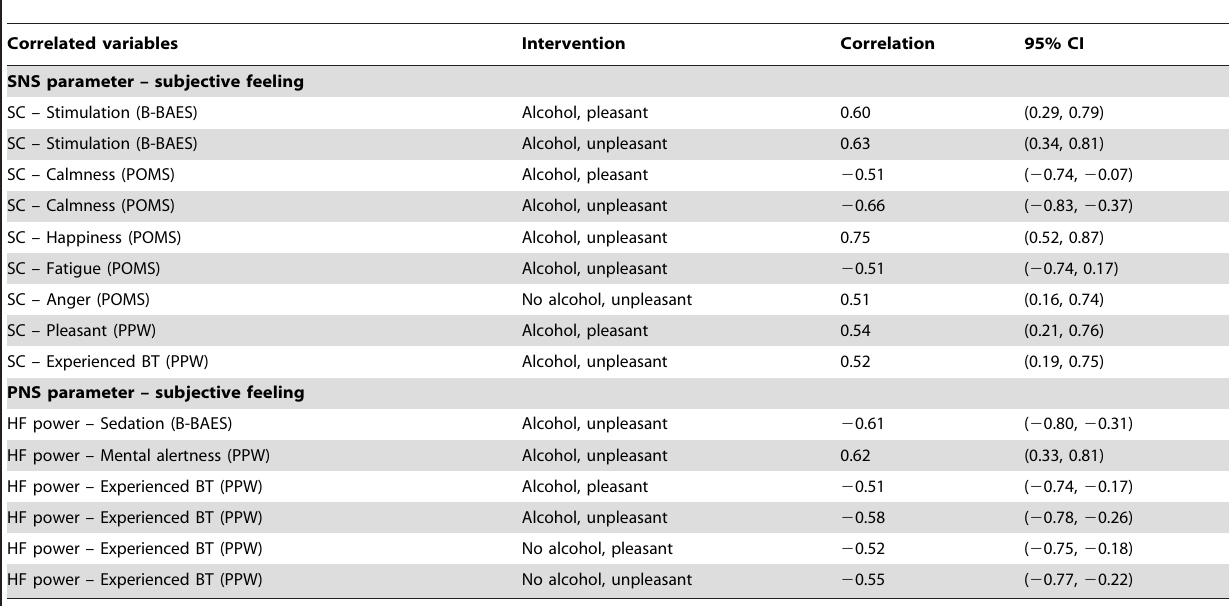
Table 2. Correlations between autonomic nervous system parameters and subjective feelings (n= 28) 1